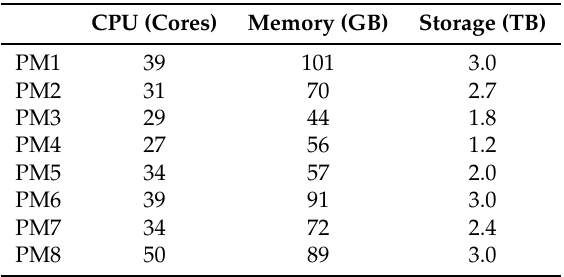
Table 3. Available resource in each